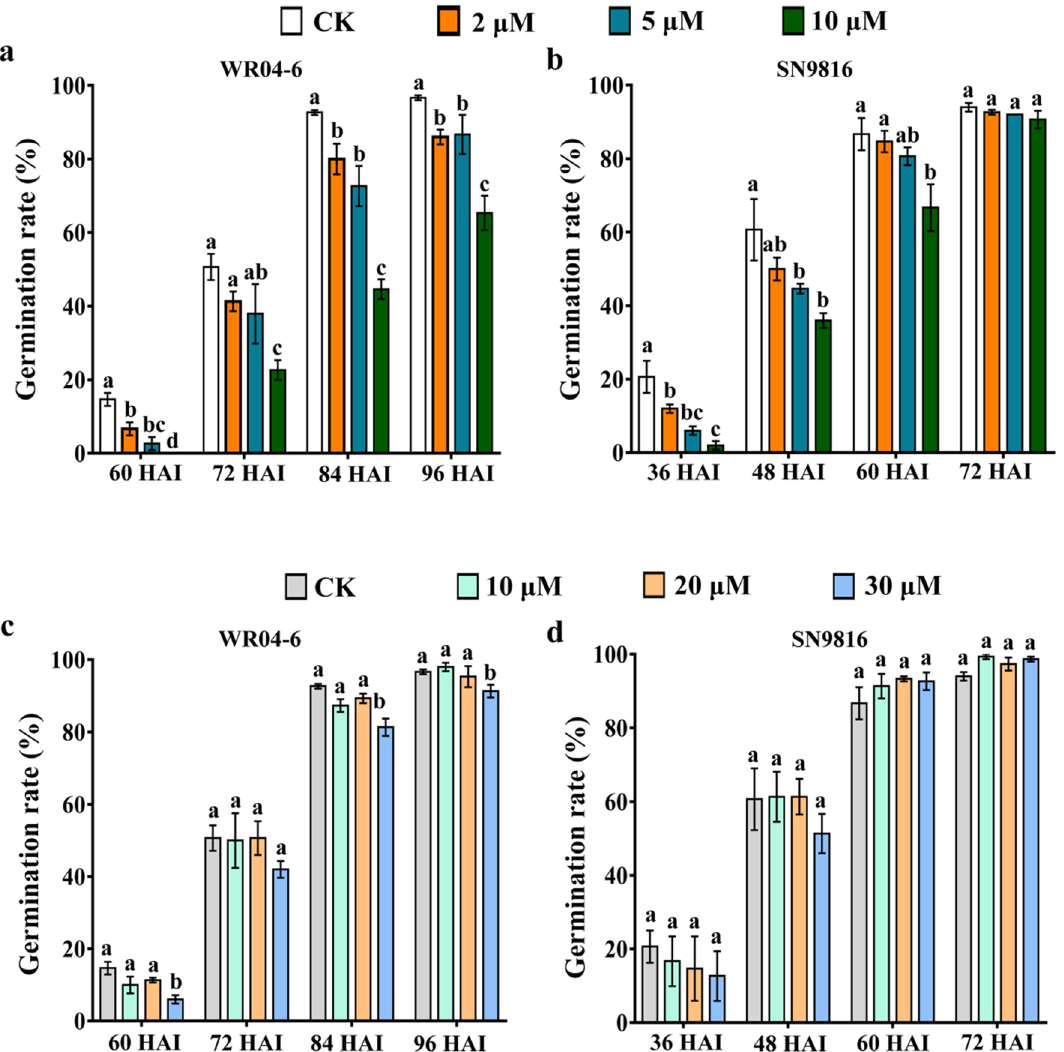
Figure 1. Germination rate (%) of WR04-6 and SN9816 seeds for different concentrations of ABA or diniconazole. ( a ) Germination rate (%) of WR04-6 seeds after ABA treatment. ( b ) Germination rate (%) of SN9816 seeds after ABA treatment. ( c ) Germination rate (%) of WR04-6 seeds after diniconazole treatment. ( d ) Germination rate (%) of SN9816 seeds after diniconazole treatment. Different letters above the bars indicate significant differences in the germination rate for different concentrations of ABA or diniconazole (one-way ANOVA. p < 0.05). Error bars represent SEs (n = concentration in unstressed SN9816 seedlings was higher than that in the WR04-6 control group. Both ABA and diniconazole resulted in a considerable decrease in the MDA concentration in SN9816 seedlings, which was 0.45- and 0.73-fold lower than that in the unstressed seedlings. The activity of the antioxidative enzymes SOD, POD, and CAT was evaluated after treatment with ABA and diniconazole. WR04-6 seedlings exposed to ABA and diniconazole experienced significantly increased SOD activity (Fig. 3b). The increased SOD activity resulting from ABA treatment was significantly greater than that after diniconazole treatment. However, there was no difference in SOD activity in the control compared with SN9816 seedlings treated with ABA or diniconazole. Similarly, POD activity in WR04-6 seedlings treated with ABA or diniconazole did not change significantly (Fig. 3c), while a significant decline was observed in SN9816 seedlings treated with ABA or diniconazole compared with the control. CAT activity in both varieties displayed similar trends when plants were exposed to stimulated stress conditions, decreasing considerably when treated with ABA but not changing when treated with diniconazole (Fig. 3d). Transcriptome sequencing and de novo assembly.